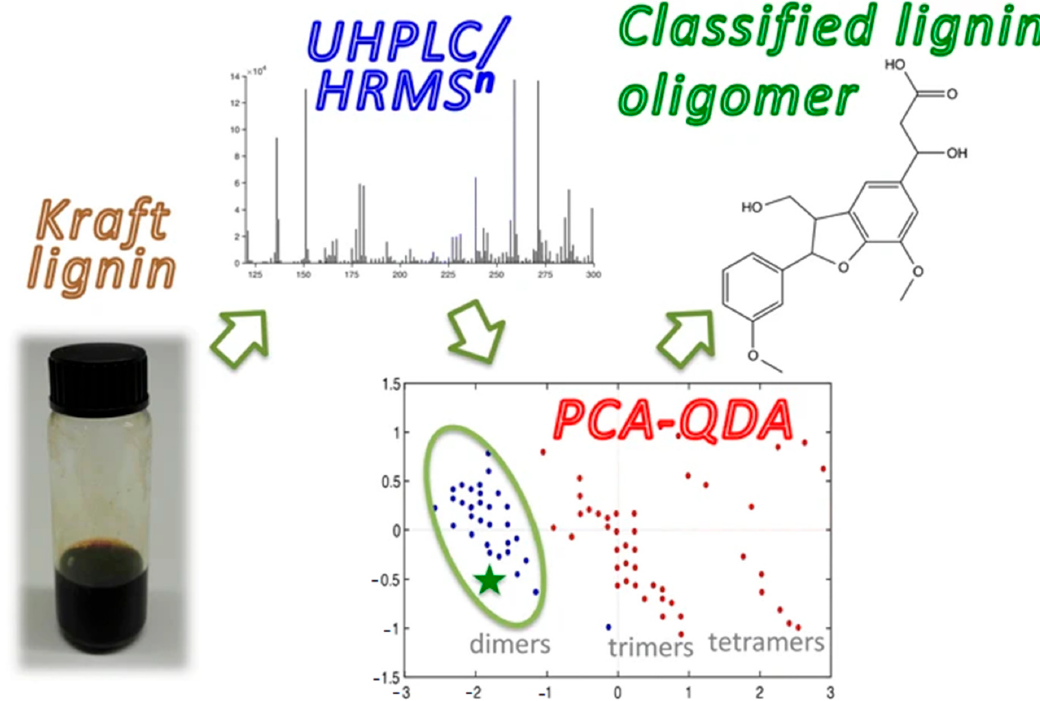
Figure 5. Workflow for a non-targeted LC-MS n strategy. Reprinted from Prothmann et al., with permission from the Springer Publishing [61].